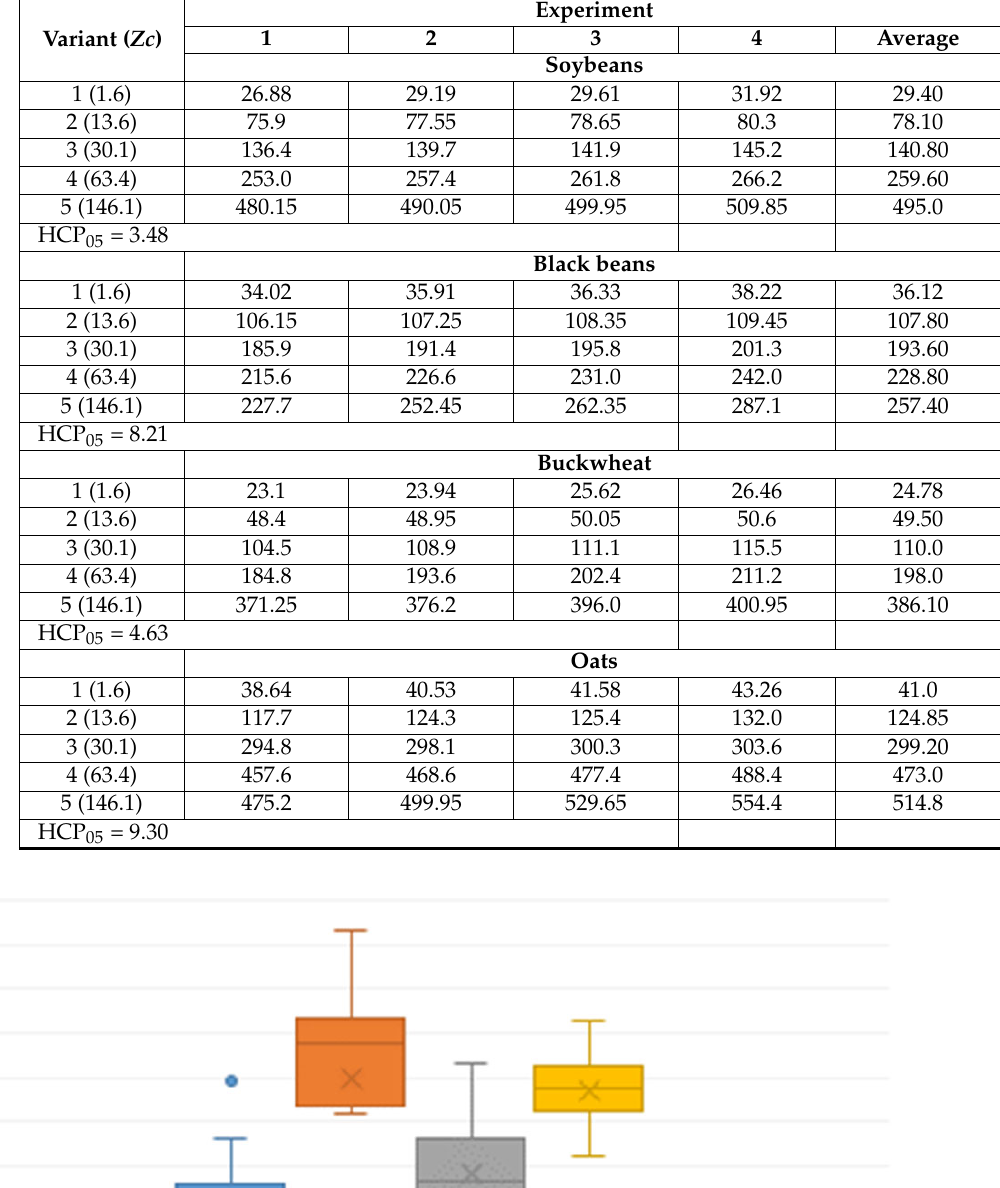
Table 3. Zinc content in the phytomass of test crops, mg/kg.